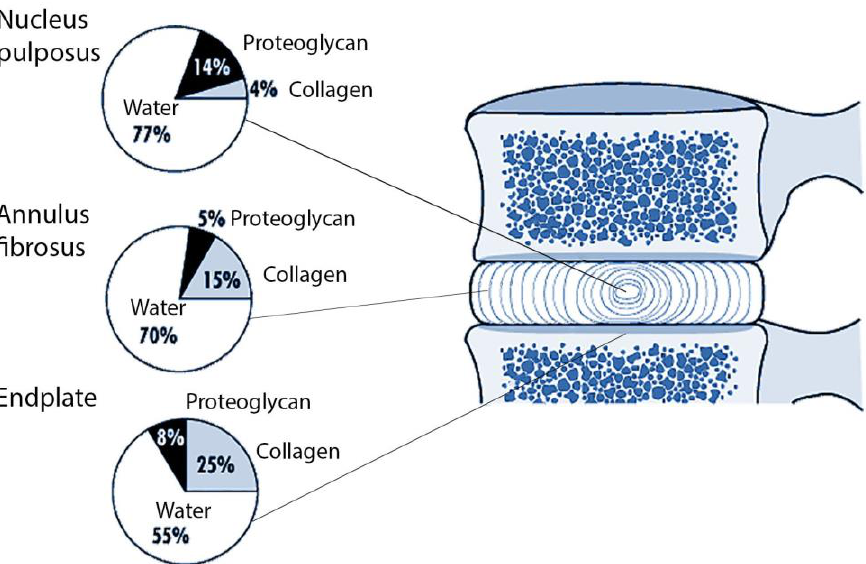
Figure 2. The relative proportions of the three main components of the normal adult intervertebral disc and the endplate.